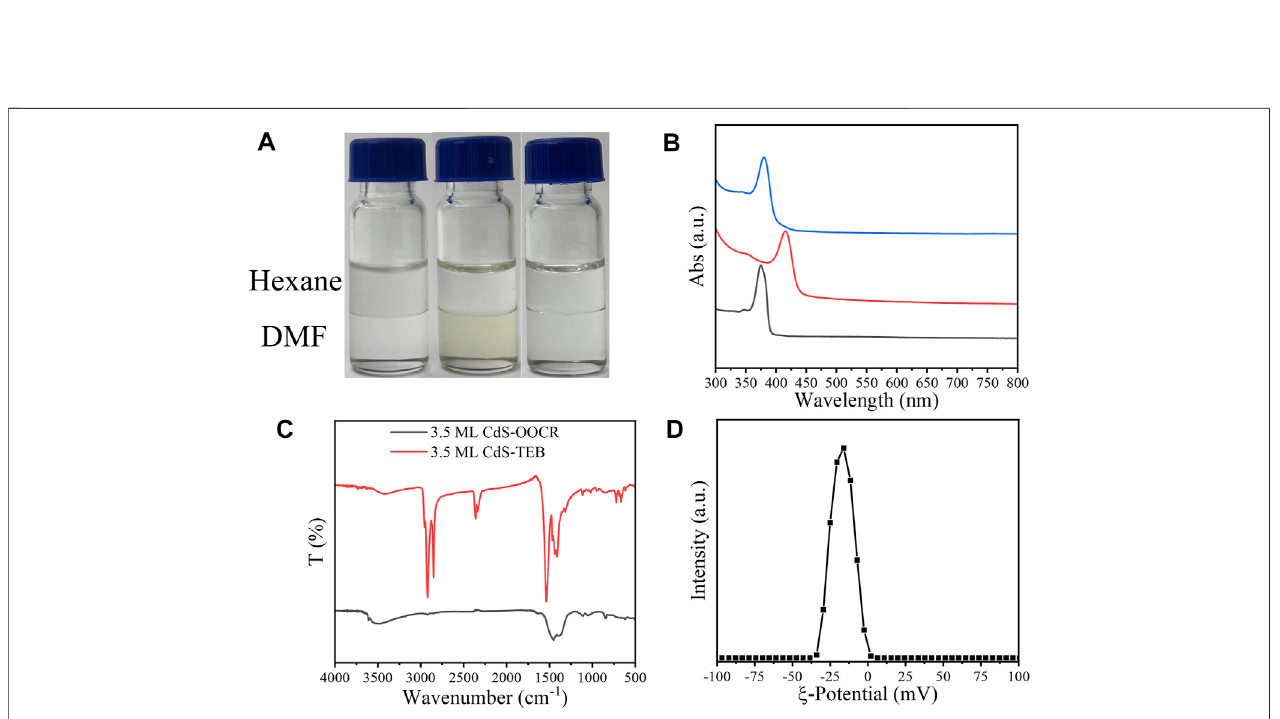
FIGURE 6 | (A) 3.5 ML CdS NPLs undergoes phase transfer from hexane to DMF in the presence of TEB. (B) UV – vis absorption spectrum (black: original NPLs; red: NPLs capped with TEB; blue: back exchange with RCOO − ), (C) FT-IR spectrum of 3.5 ML Zb-CdS capped with RCOO- and TEB. (D) The zeta potential of 3.5 ML ZB CdS-TEB in